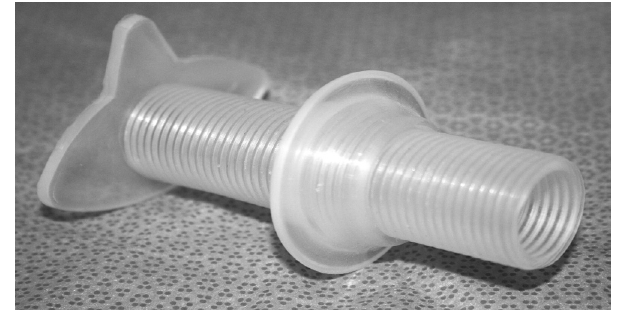
Figure 1 - Photograph of the device